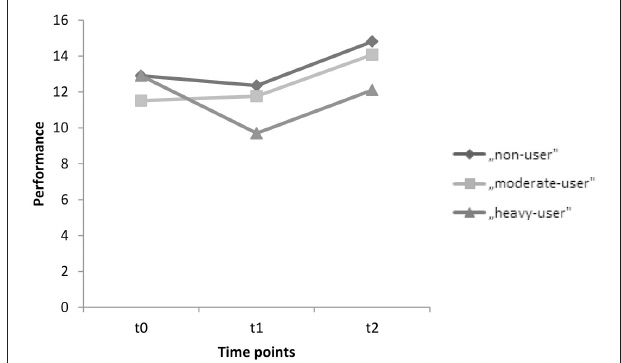
FIGURE 2 | Mean performances on the immediate recall test for time points t0, t1, and t2 for the groups, non-users, moderate-users, and heavy-users.